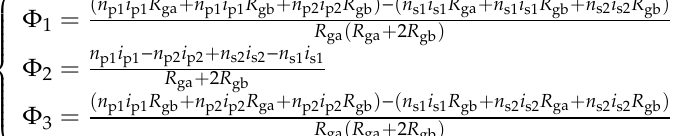
Figure 6. The equivalent reluctance model of the improved EI core structure.